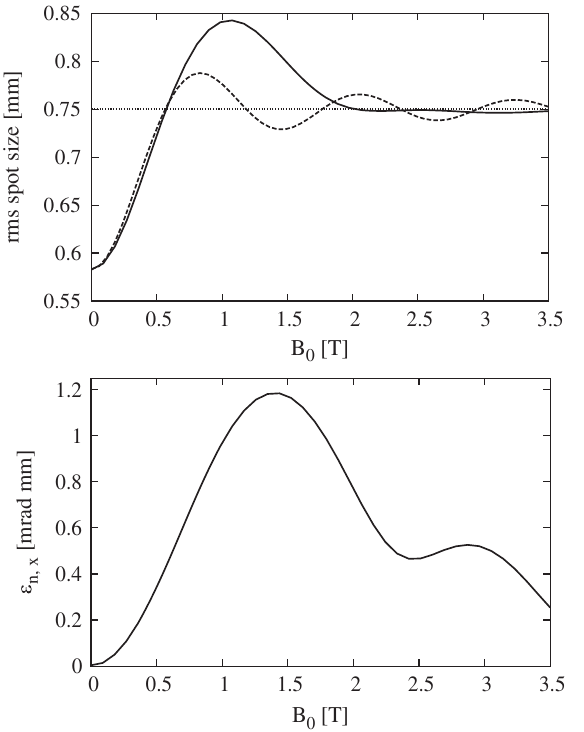
FIG. 22. Top: Emittance development inside a cavity cell for a solenoid field of 1.5 T (solid line). For comparison, the emittance development for the case without a solenoid field is included (dashed line; see also Fig. 19, which shows an equal plot but for a higher energy). Bottom: Emittance versus strength of the solenoid field for a single-cell cavity (solid line), a two-cell cavity (dashed line), and a three-cell cavity (dotted